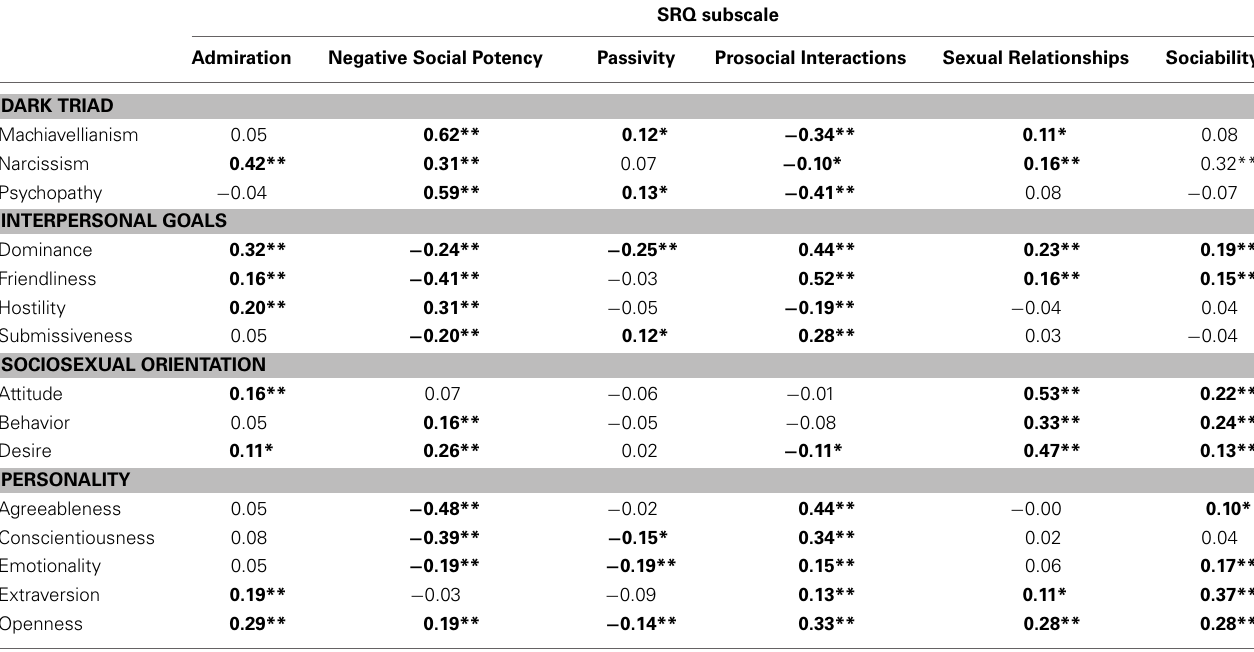
Table 5 | Pearson correlations between SRQ subscales and external